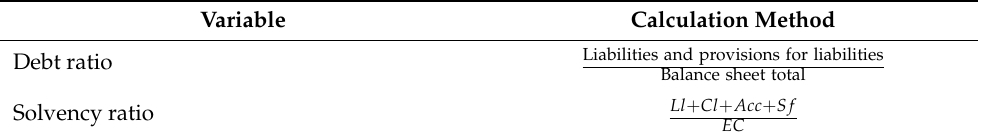
Table 3. Debt and solvency ratios—calculation